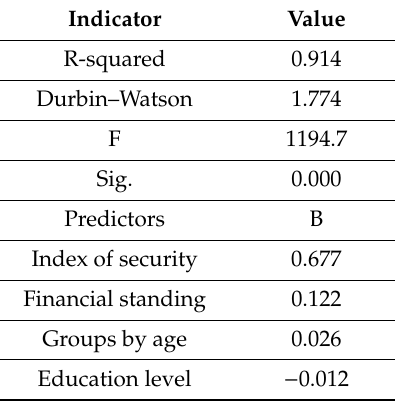
Table A4. Regression model C. Dependent variable: trust index.